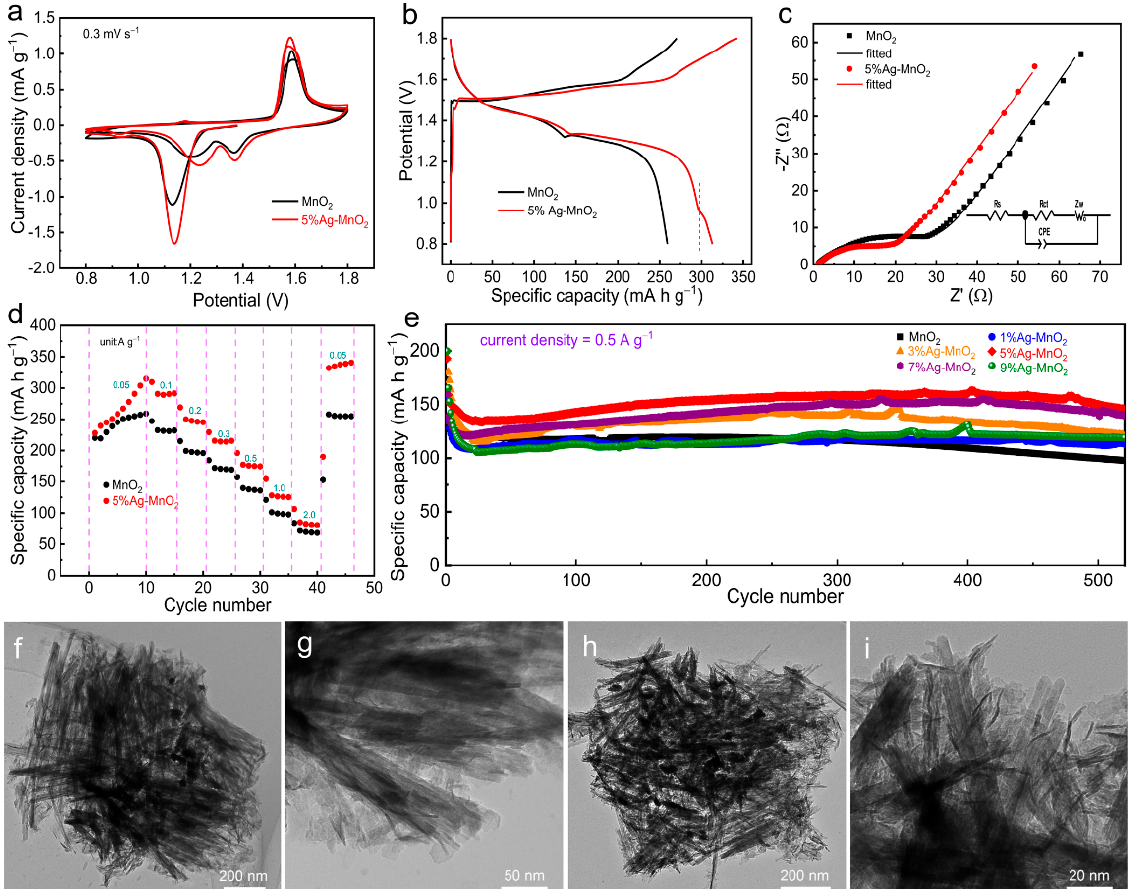
Figure 3. ( a ) CV curves at a scan rate of 0.3 mV s − 1 , ( b ) GCD curves at a specific current of 0.05 A g − 1 , ( c ) EIS spectra, and ( d ) rate performances of ZIBs based on pure MnO 2 and 5%Ag-MnO 2 . ( e ) Long- term cycling performance at a specific current of 0.5 A g − 1 for the MnO 2 doped with different amounts of Ag. TEM images of 5%Ag-MnO 2 after being cycled at 0.5 A g − 1 for ( f , g ) 50 and ( h , i ) 500 cycles.